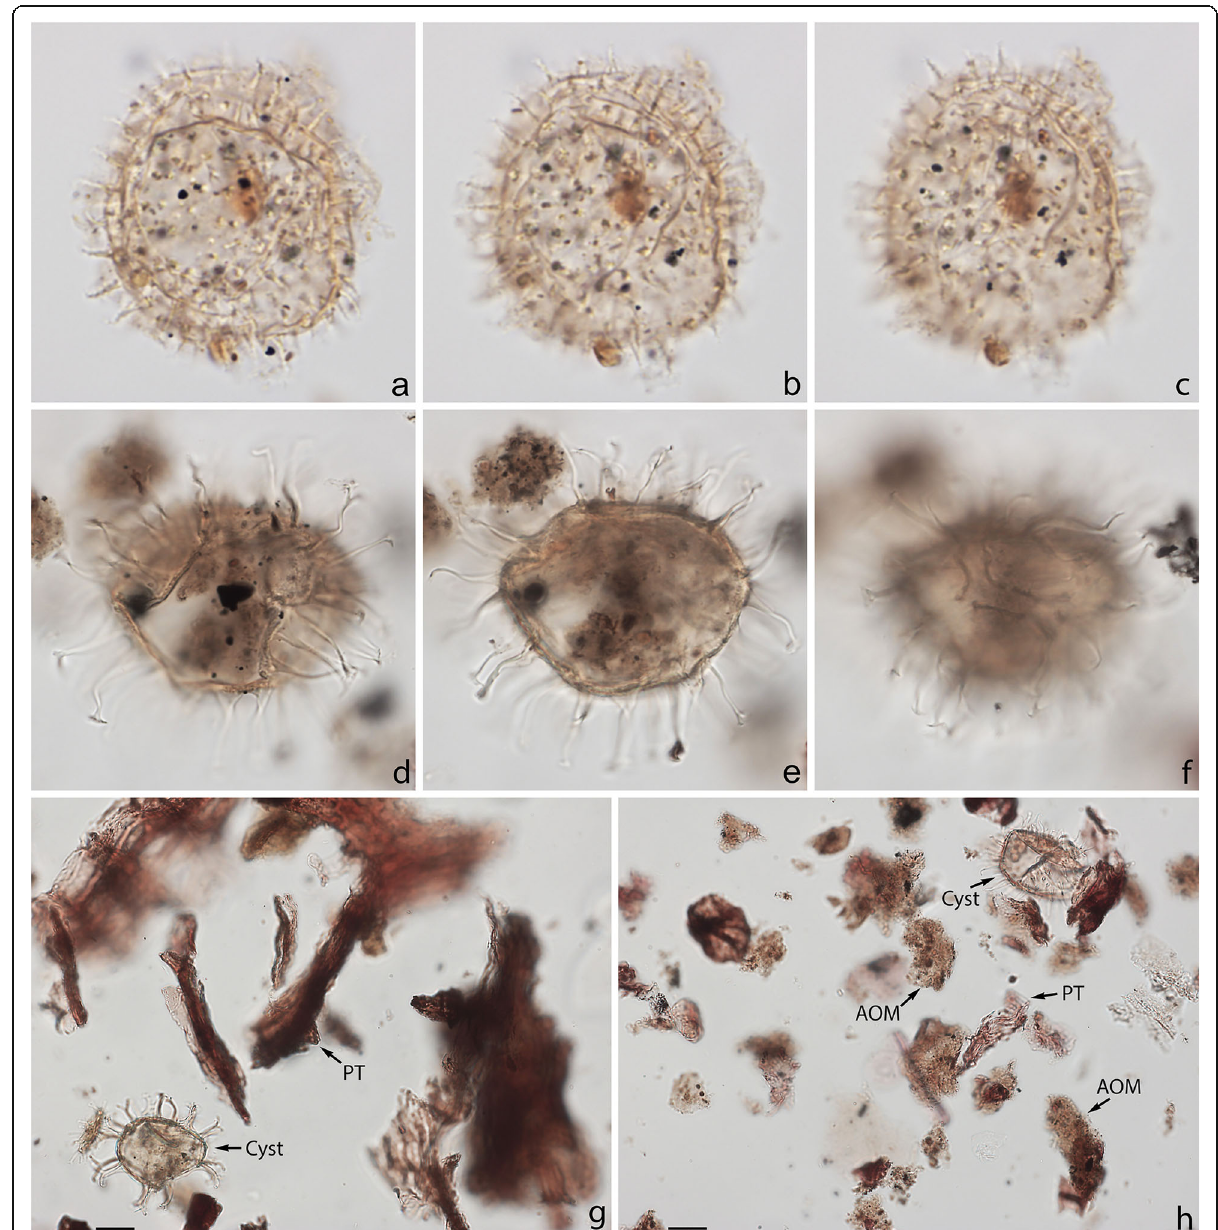
Fig. 14 An acritarch ( a – c ), a presumed reworked dinoflagellate cyst ( d – f ), and palynofacies ( g , h ) from the Chiba composite section. Max. dia. = maximum diameter. EF = England Finder reference. a – c Nannobarbophora walldalei , uncertain view at upper, mid-, and lower foci; central body max. dia. 29 μ m; sample TB2 30, slide 2 (10 μ m), EF E15/3. d – f Cleistosphaeridium placacanthum (presumed reworked), apical view at upper, mid- and lower foci showing granulate central body surface with well-developed penitabular ridges; central body max. dia. 53 μ m; sample TB 114, slide 1 (10 μ m), EF P16/4. g , h Organic residue sieved at 10 μ m showing ( g ) terrestrially dominated (sample TB2 105, slide 1, EF D21/4) and ( h